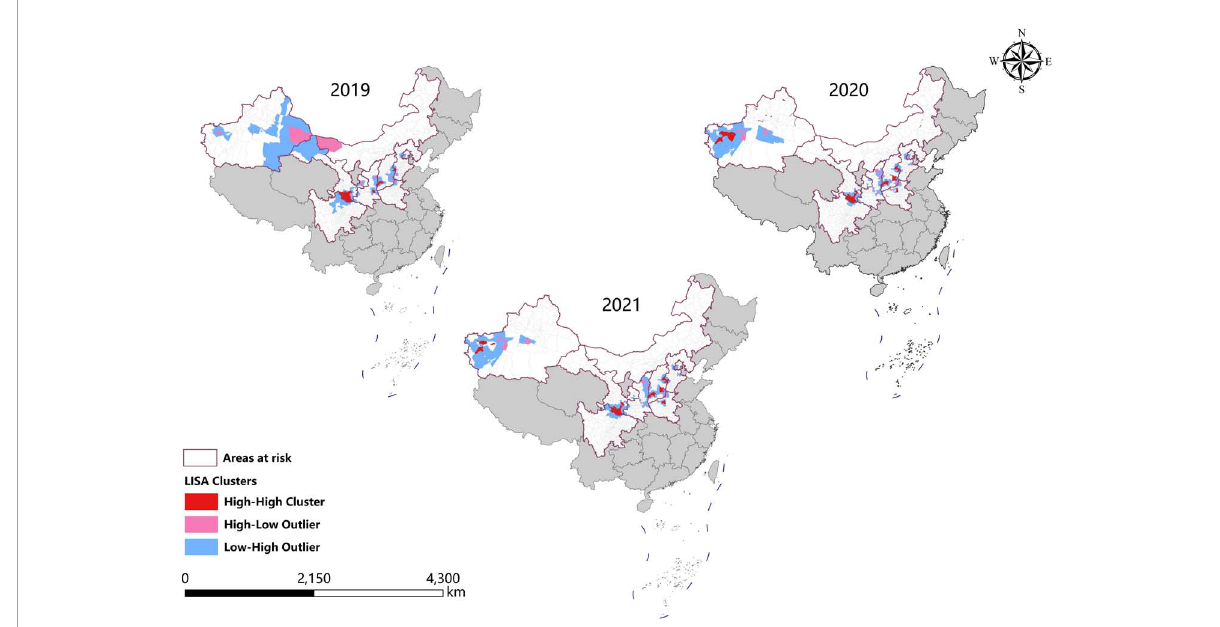
FIGURE4 Spatial autocorrelation analysis of visceral leishmaniasis incidence in mainland China from 2019 to 2021.